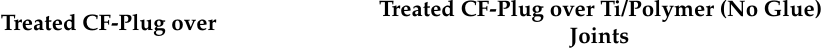
Table 2. Summary of improvements in UTS ( σ b ) (MPa) of: treated (HLEBI, or Ni plating) over un- treated CF plug joints (left two columns); and total improvement of treated CF plug over Ti/polymer (no plug, no glue) joints (right two columns). Data is from: Hasegawa, Faudree, Matsumuara, Jimbo, and Nishi (2016) [10]; Hasegawa, Faudree, Enomoto, Takase, Kimura, Tonegawa, Jimbo, Salvia, and Nishi (2017) [11]; and Nishi, Uchida, Faudree, Kaneko, and Kimura (2019) [46], for titanium joints with ABS, PC, and epoxy, respectively.